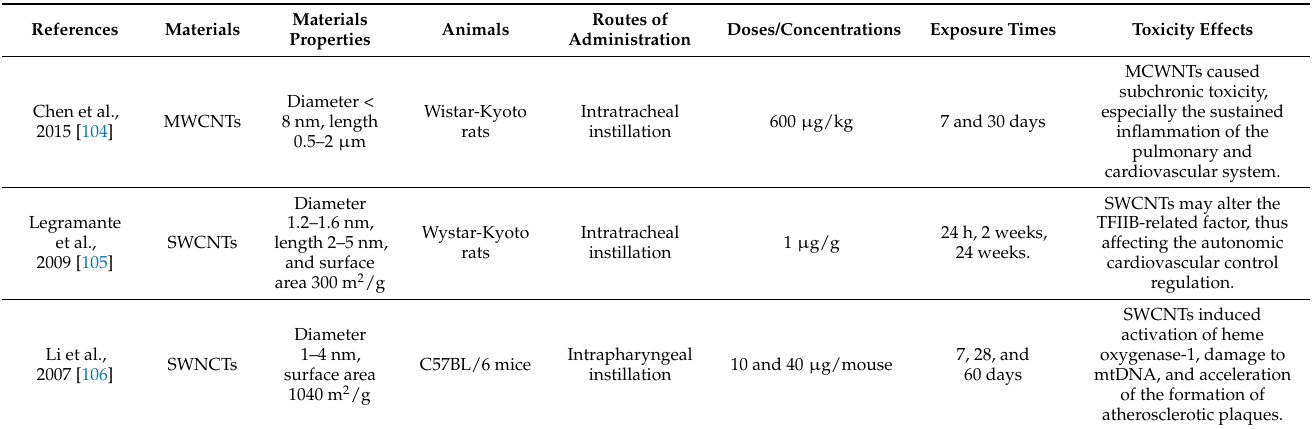
Table 5. Cardiac toxicity of pristine carbon nanotubes using rodents as animal